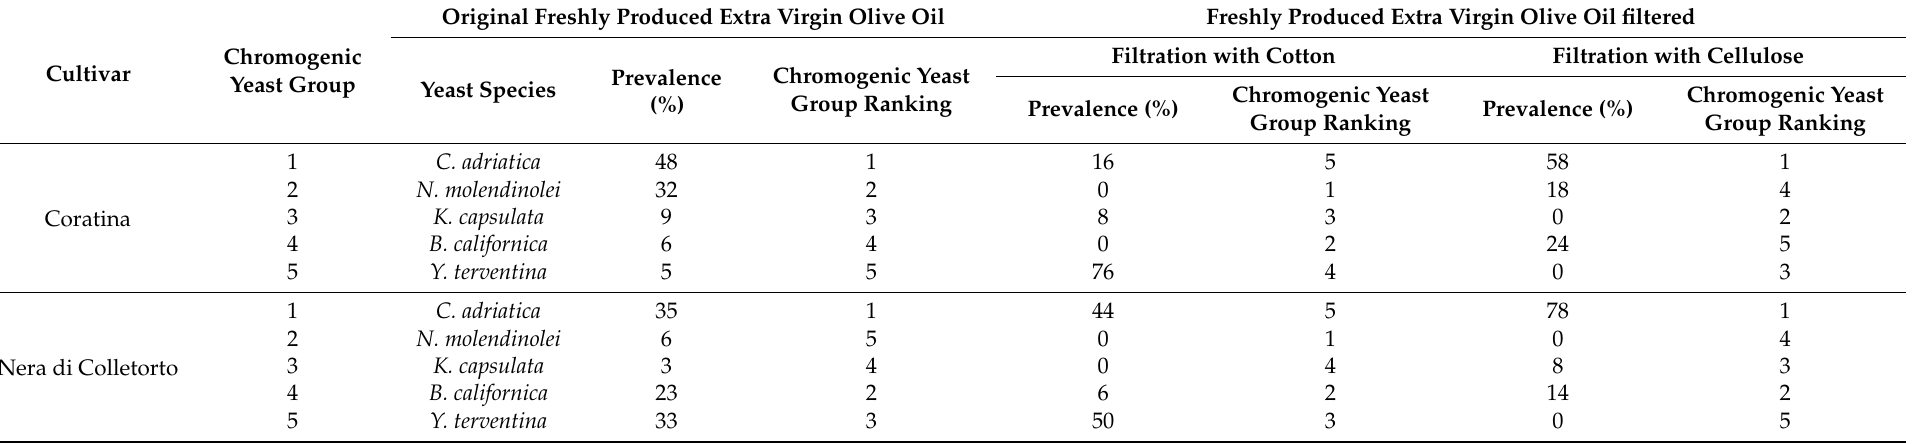
Table 5. Distribution of predominant yeast species in freshly produced extra virgin olive oil from two monocultivars subjected to filtration.